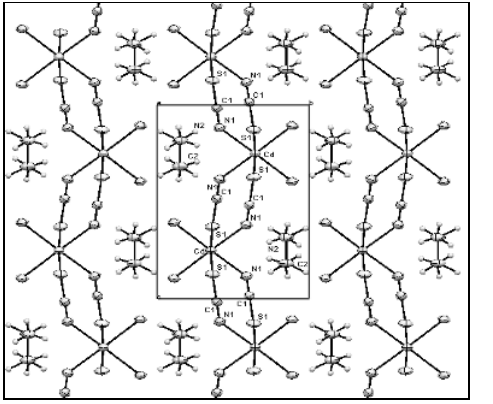
Fig.2. Projection along the a-axis of C